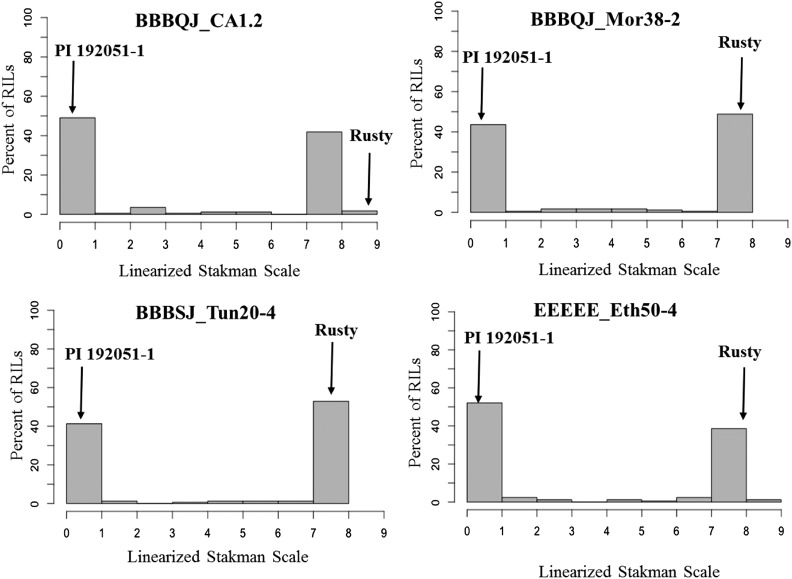
Distributions of the seedling response data for Puccinia triticina isolates BBBQJ_CA1.2, BBBQJ_Mor38-2, BBBSJ_Tun20-4, and EEEE_Eth50-4 for recombinant inbred lines (RILs) from the cross Rusty × PI 192051-1. Distribution is expressed as the percent individuals within a linearized Stakman scale (0-9). Median phenotypes for PI 192051-1 and Rusty are indicated on the graph.